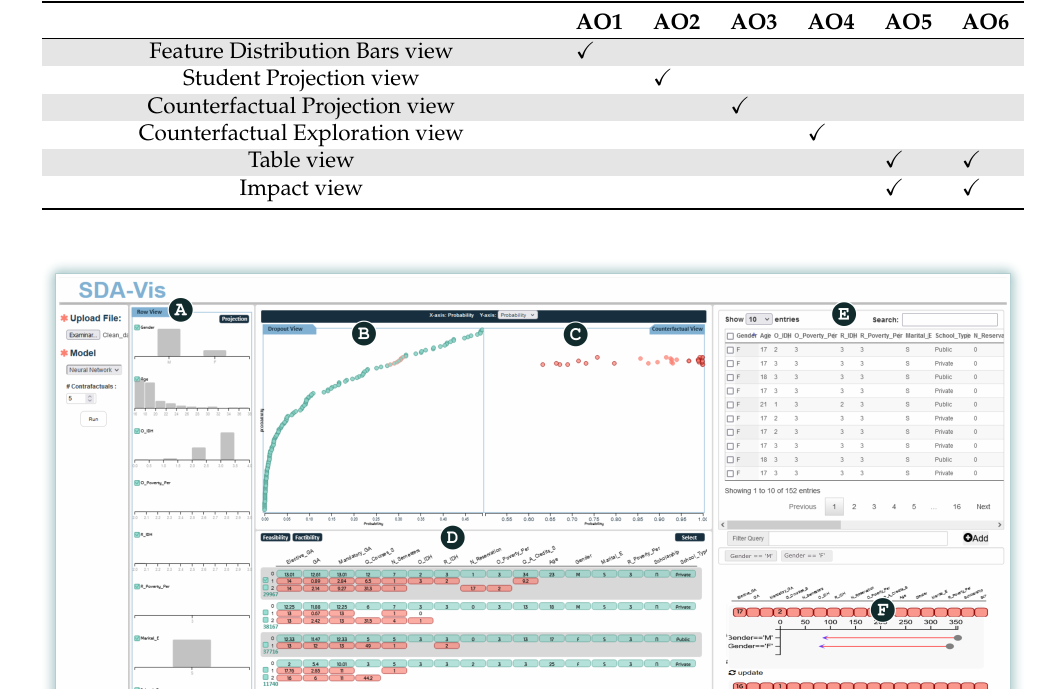
Table 2. Analytical objectives and their related visualization tools.